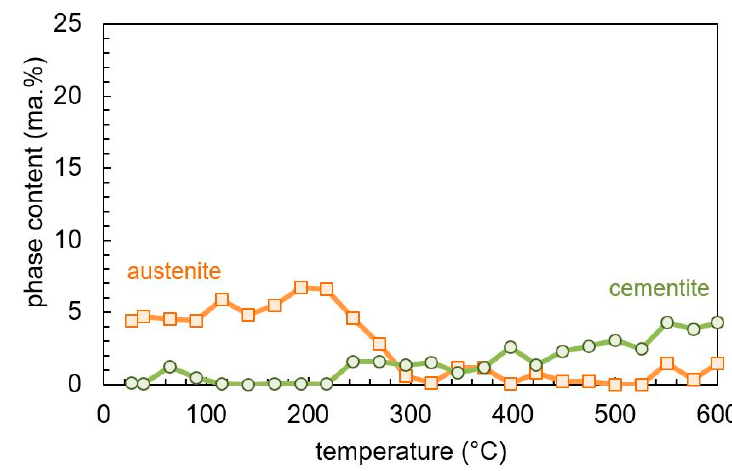
Figure 6. Phase content evolution during tempering of martensitic SAE 4140 determined by in-situ X- ray measurement.